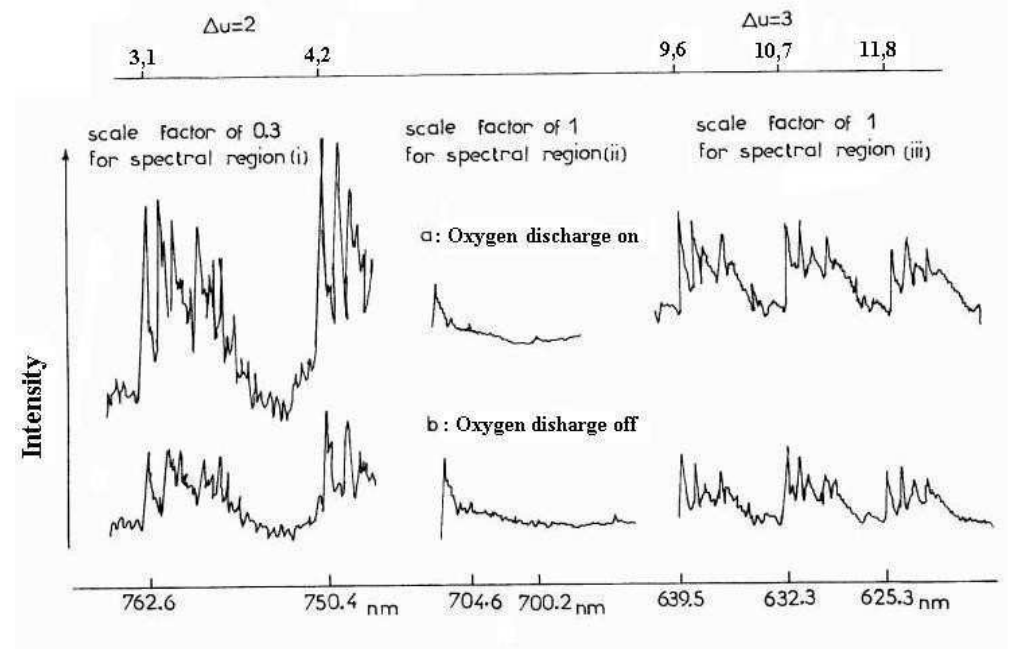
Fig. 2 N 2 (B 3 Πg → A 3 Σu + ) emission spectra showing the ∆ υ =2, and ∆ υ =3 band sequences of the first positive band system (1pbs) , with and without discharged O 2 . The vibrational levels of each band in a 1pbs N 2 (B 3 Πg → A 3 Σu + ) sequence are shown over each band with the N 2 (B 3 Πg) vibrational level of each band shown first. The spectra were obtained by adding (a, top spectra) discharged oxygen to a flowing nitrogen afterglow of discharged nitrogen, and (b, lower spectra) undischarged oxygen to the same nitrogen afterglow with the same scale factor. The three spectral regions (i), (ii) and (iii) extend on both sides of the peak wavelength for singlet molecular oxygen red and near IR emissions: (i) the ∼ 761.8 nm for the O 2 (b 1 Σ g + ) emission, (ii) the ∼ 703.2 nm for the 0,0 - 0,1 2O 2 (a 1 ∆ g ) emission, and (iii) the ∼ 633.4 nm for the 0,0 - 0,0 2O 2 (a 1 ∆ g ) emission. No such emissions are shown in these spectra. The top spectra in the spectral region (i) and (iii) show N 2 1pbs enhancement. In all cases P N mbar and P O = 0.9 mbar. The spectra are not corrected for grating and detector nonuniform 2 spectral